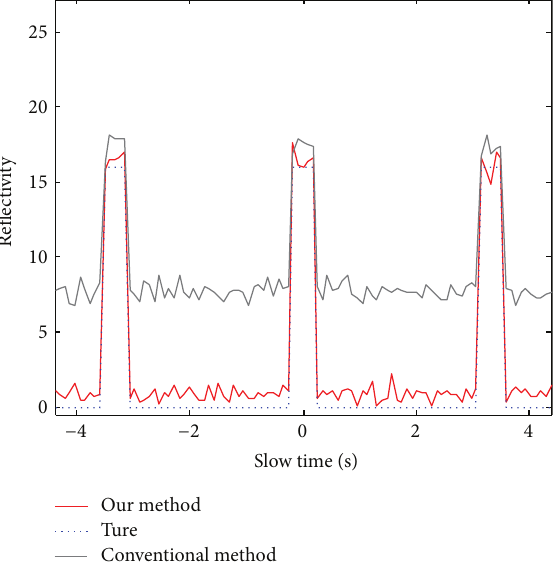
Figure 12: Recovered reflectivity with respect to slow time.